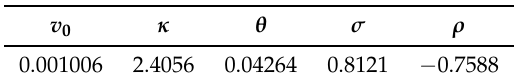
Table 5. Heston parameters calibrated against SPX500